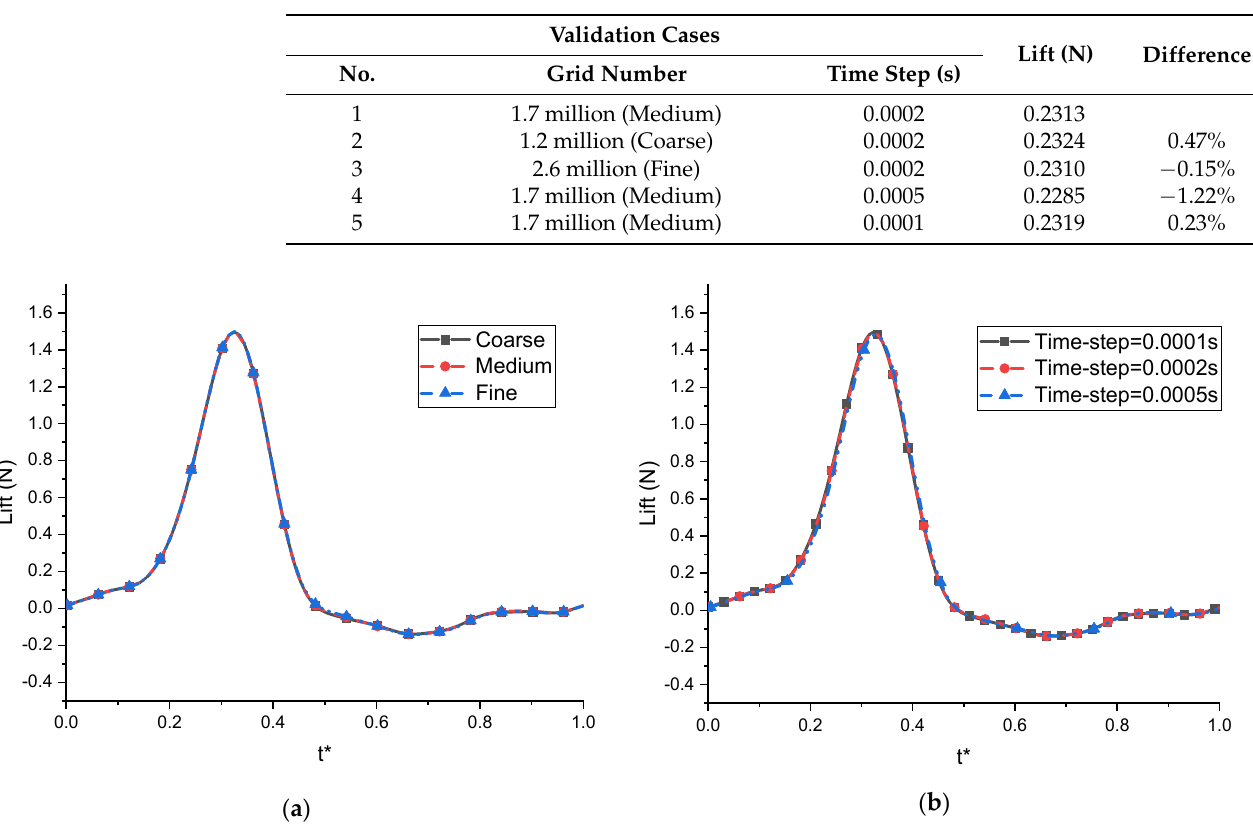
Figure 5. Convergence studies of the CFD simulation: ( a ) grid convergence tests; ( b ) time-step convergence tests.